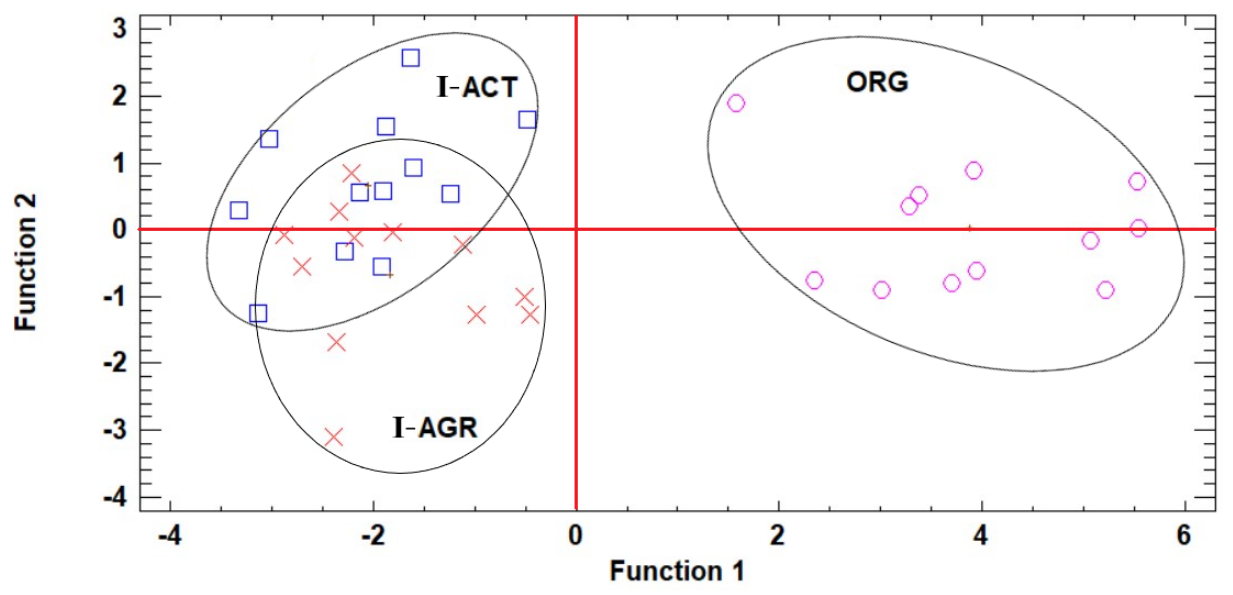
Figure 3. Plot of the discriminant functions produced by the three treatments based on yield, fruit quality, and phytochemical attributes. Abbreviations: ORG, organic; I-AGR, integrated based on Agrobiosol amendment; I-ACT, integrated based on Activit amendment.